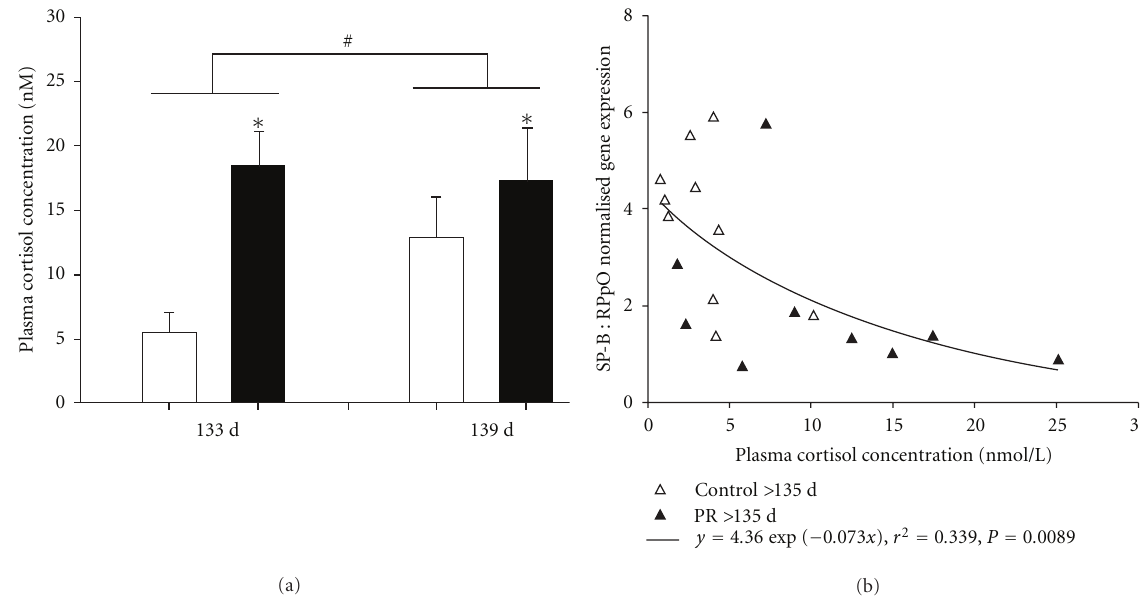
Figure 6: The chronically hypoxemic PR sheep fetus (black bars) has higher plasma cortisol concentrations than the normally grown fetus (open bars) (a). Relative surfactant protein B (SP-B) mRNA expression is inversely correlated with plasma cortisol concentration (b). The figure is reproduced with permission from [126].